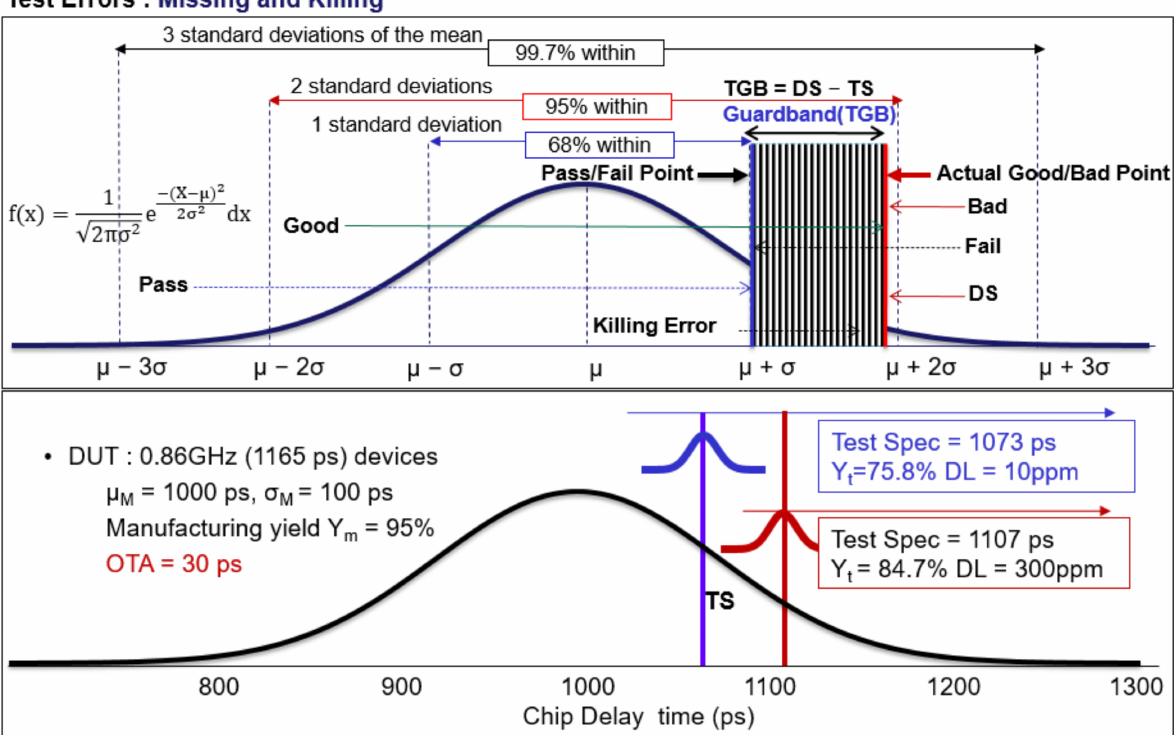
Figure 6. The test guardband affects the test yield and test quality of the test. Test quality at DL = 300 ppm with the test guardband to the right (TGB) (the smaller the test guardband is set) shows that test yield is better but has poor test quality. In contrast, test quality at DL = 10 ppm with the test guardband to the left (the larger the test guardband setting is) shows that test yield is poor but has better test quality. The larger the guardband, the higher the rate of killing error, but the quality of the shipment can be